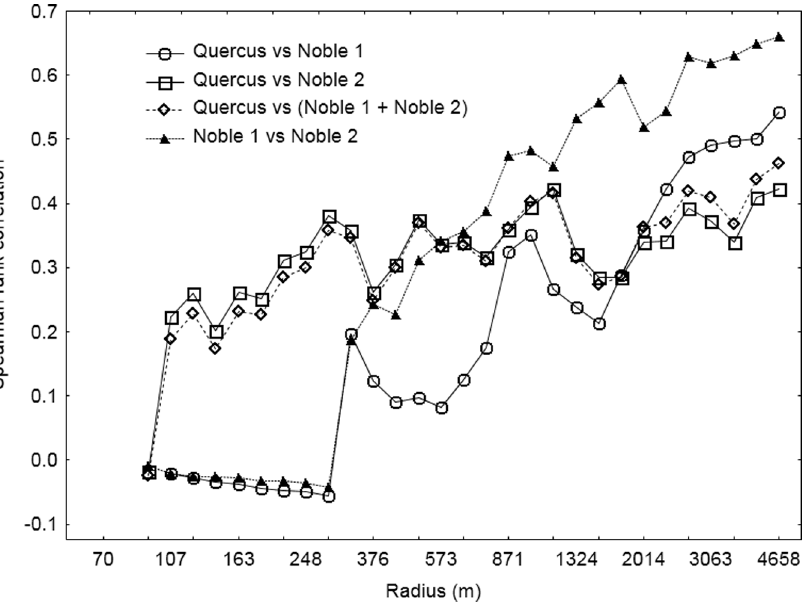
Figure 5. Correlation between the densities of tree groups that explained the occurrence of Elaterferrugineus .